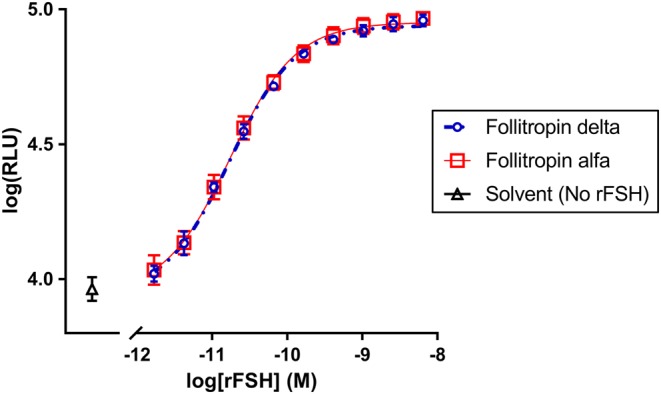
Production of cAMP in response to activation of the human FSH receptor in stably transfected HEK-293 cells was measured across the indicated concentrations of follitropin delta (open circles, blue), follitropin alfa (open squares, red) or no recombinant FSH (open triangles, black) with increasing luminescence (RLU) proportional to increasing cAMP present. Each concentration of rFSH proteins was tested in quadruplicate, with the mean and s.d. shown.